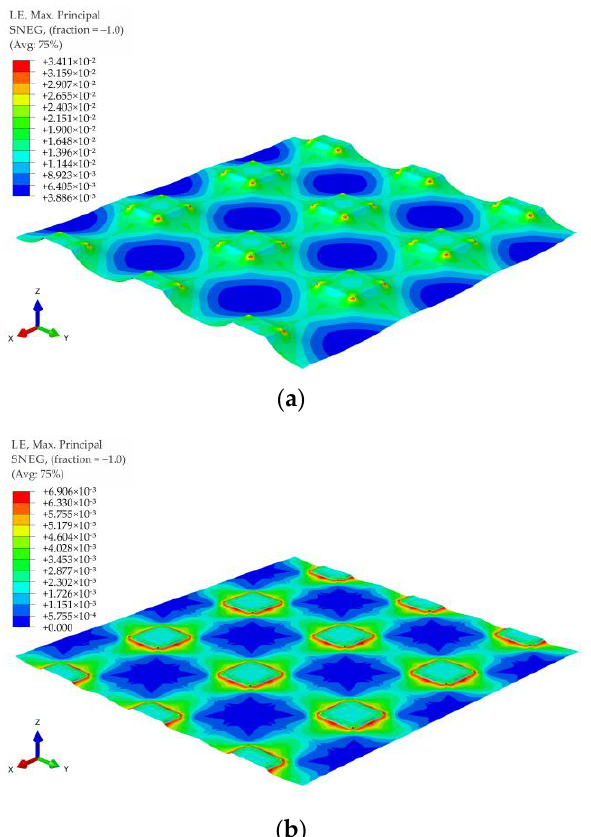
Figure 30. Deformation and maximum principal strain in reinforcement for inverse pyramid shape load distribution, variant A2: ( a ) k = 0 kN/m 3 ; ( b ) k = 500 kN/m 3 .